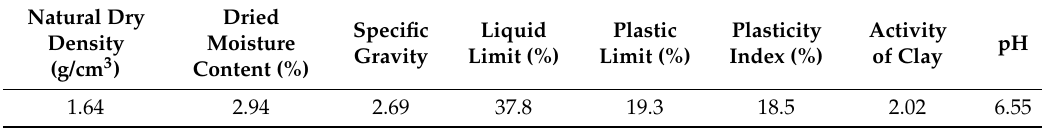
Figure 1. Soil particle size distribution. Table 1. Physical properties of soil sample.